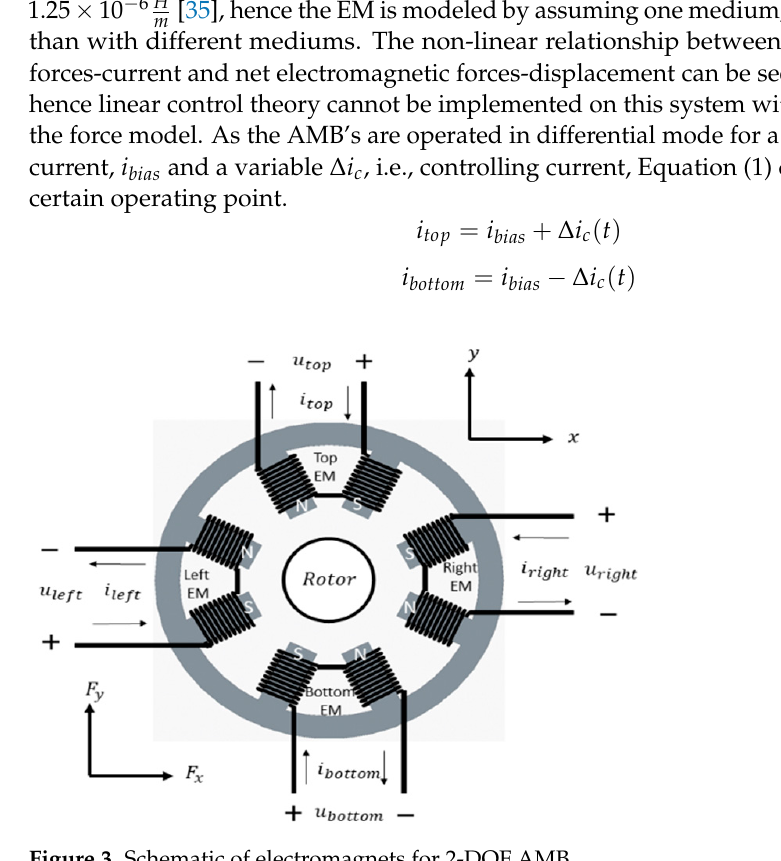
Figure 3. Schematic of electromagnets for 2-DOF AMB.